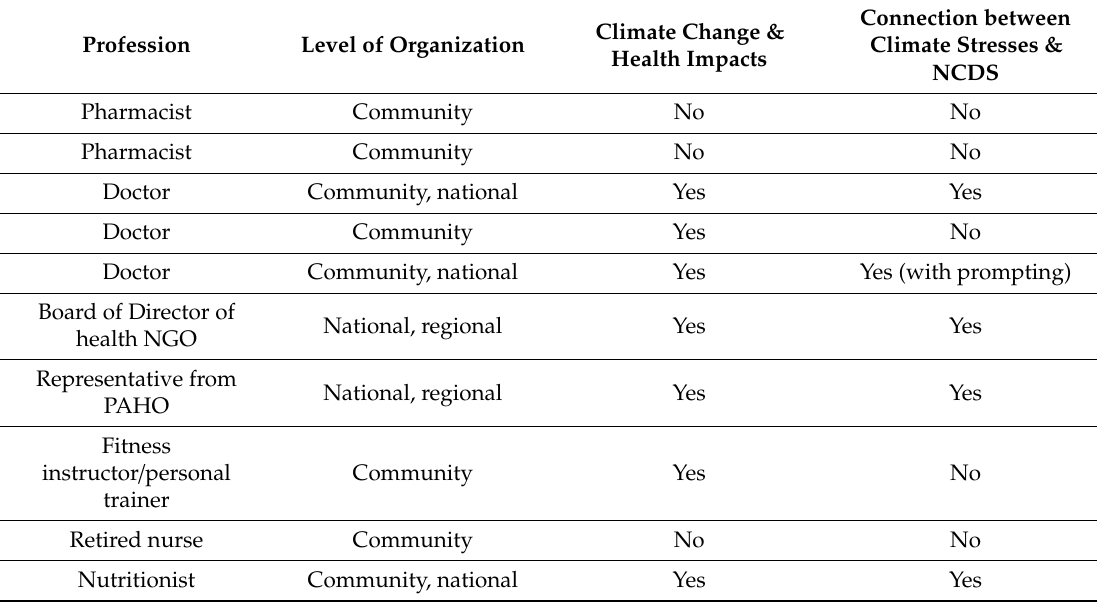
Table 4. Key informant knowledge of climate change and health